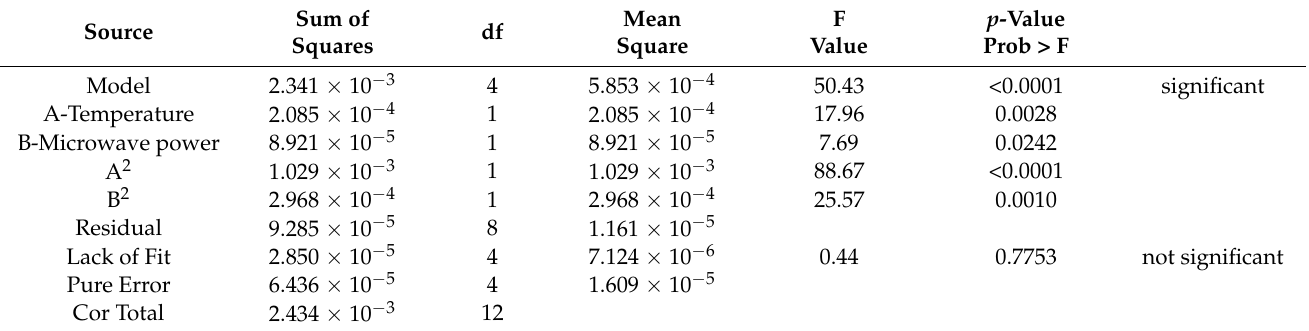
Table 9. Analysis of variance for color response using RSM.